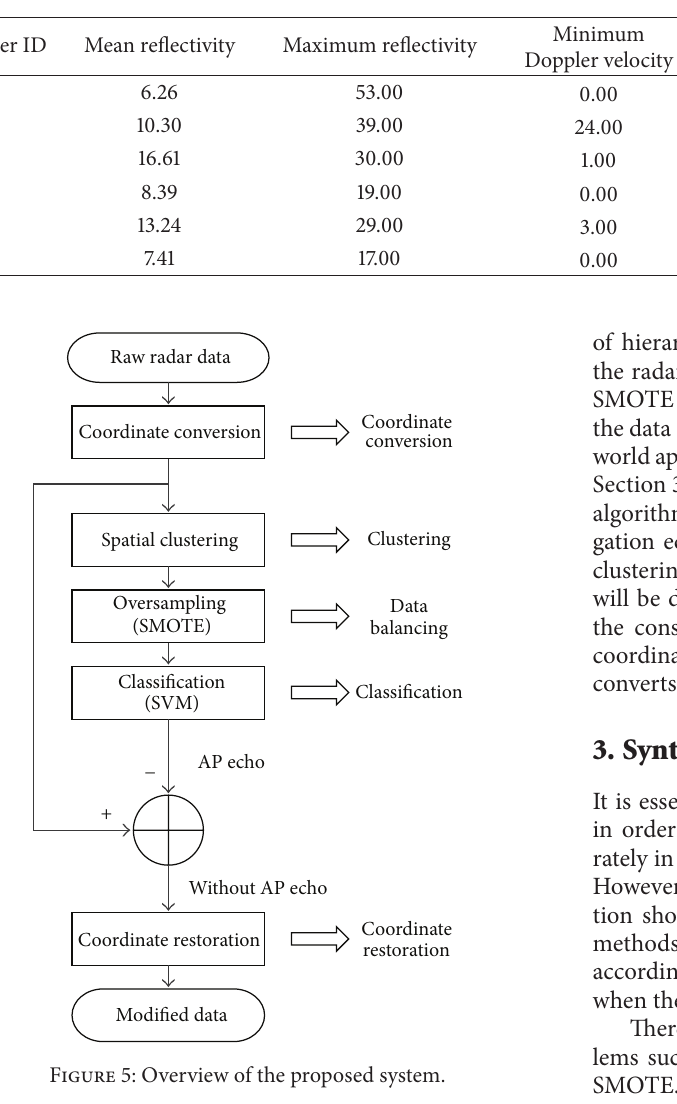
Table 1: Learning dataset from derived clusters.